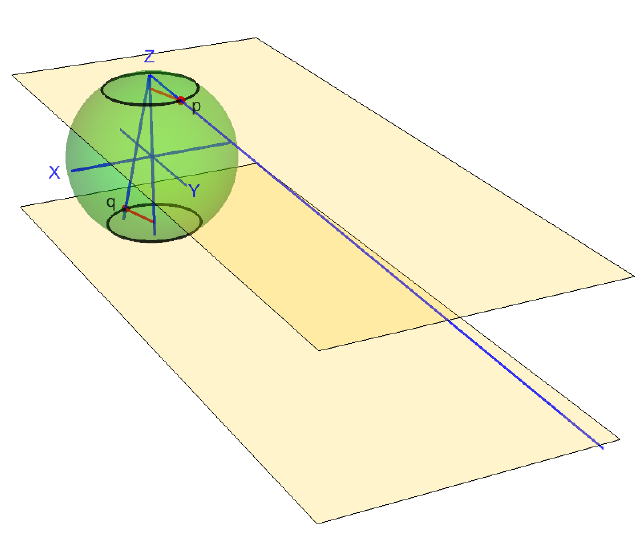
Figure 2 . Stereographic projection for two incoming particles whose momenta lie close to the z